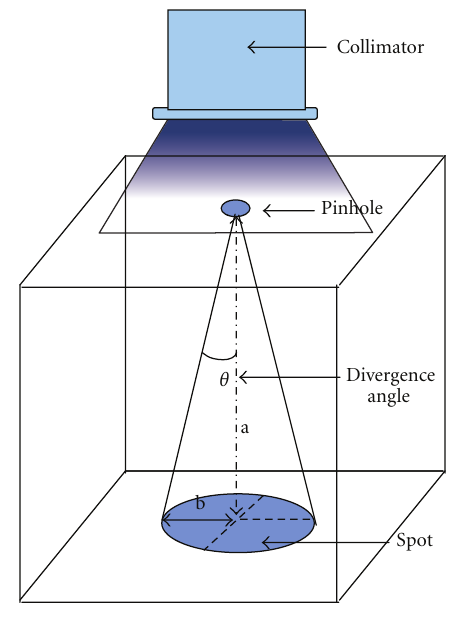
Figure 2: Schematic diagram of regulation collimator.